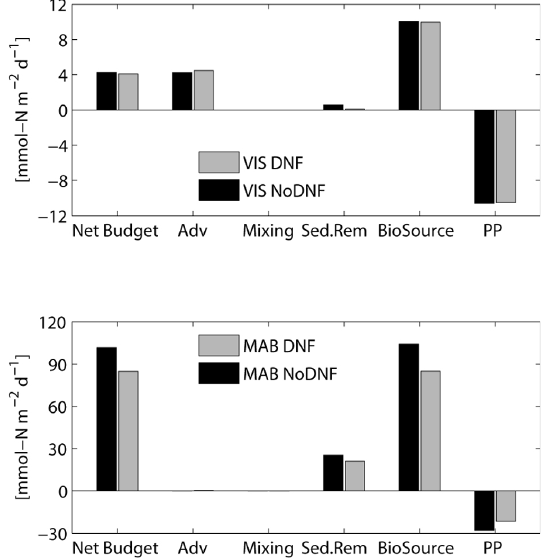
Fig. 6. Contributions to the DIN budget for the whole water column of the modelled shelves (depth ≤ 200m), averaged over the 75 days of the analysis period: (top) VIS and (bottom) MAB. Experiments with and without denitrification in the sediments are shown as grey and black bars, respectively. The bottom axis reads: net budget (sum all of budget terms), advection (horizontal plus vertical), vertical mixing, sediment remineralization, biological sources of DIN in the water column (remineralization of organic matter and zooplankton respiration) and primary production. Positive fluxes represent a gain of DIN by the shelf